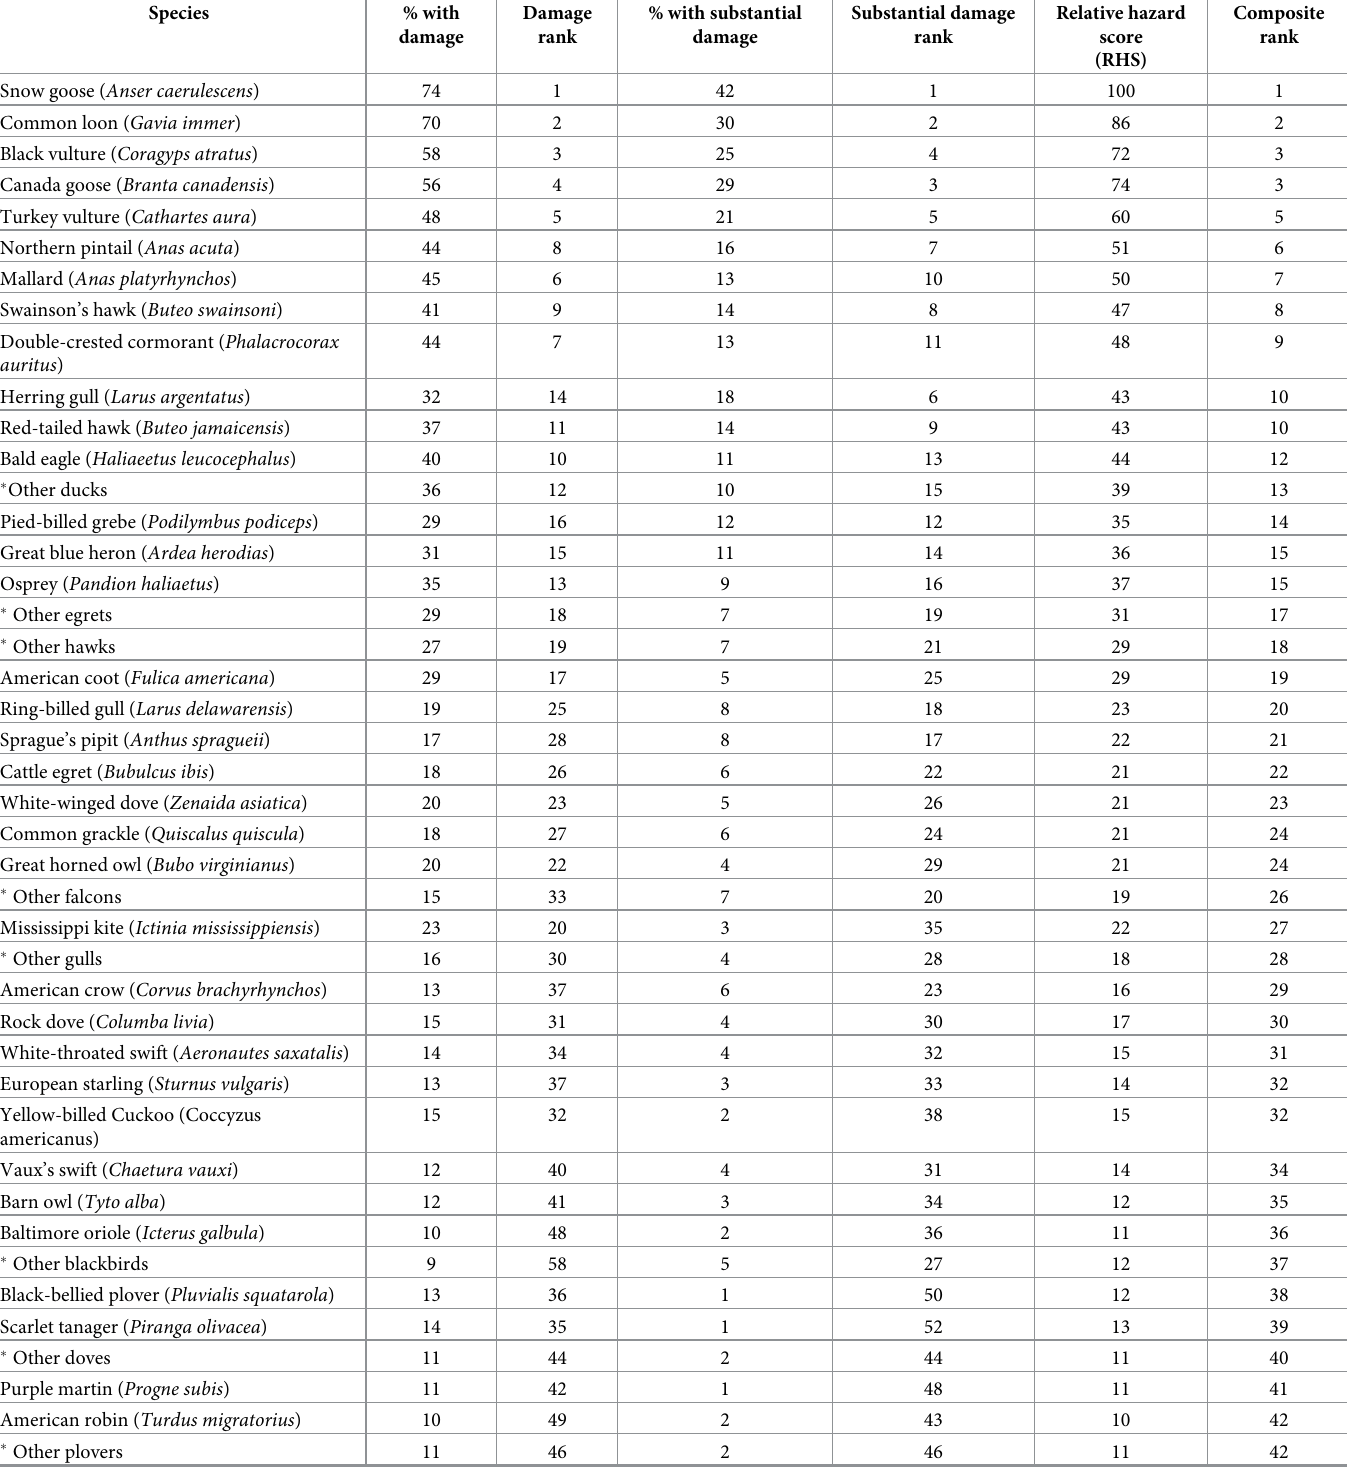
Table 2. Relative hazard scores (RHS) for 108 species groups from most to least hazardous for military aircraft within the United States. Species % with